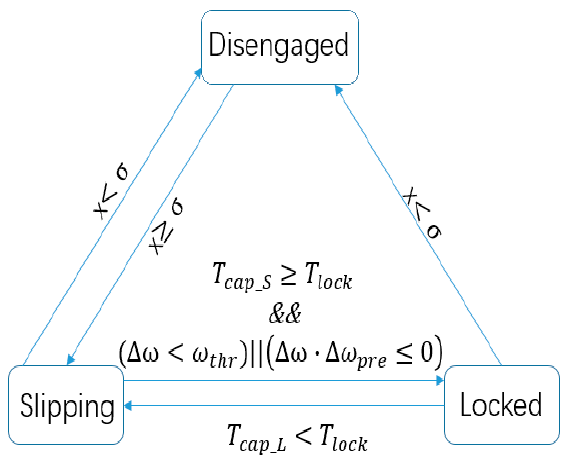
Figure 11. EMTC modes transition illustration.